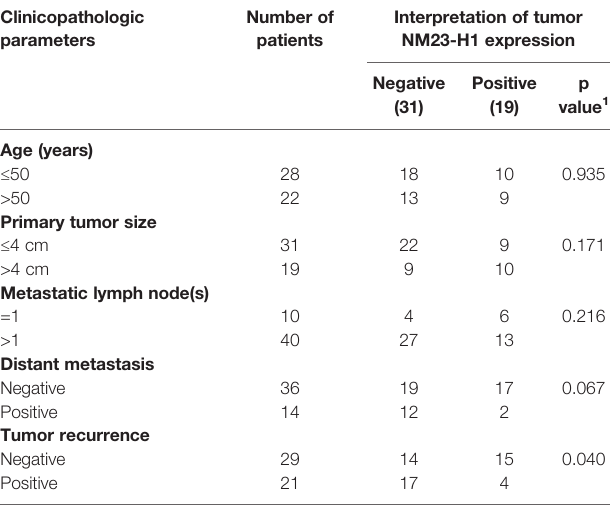
TABLE 1 | Relationship between NM23-H1 expression in head and neck squamous cell carcinoma and clinicopathologic parameters of 50 patients with resectable cervical metastasis treated by postoperative radiation.